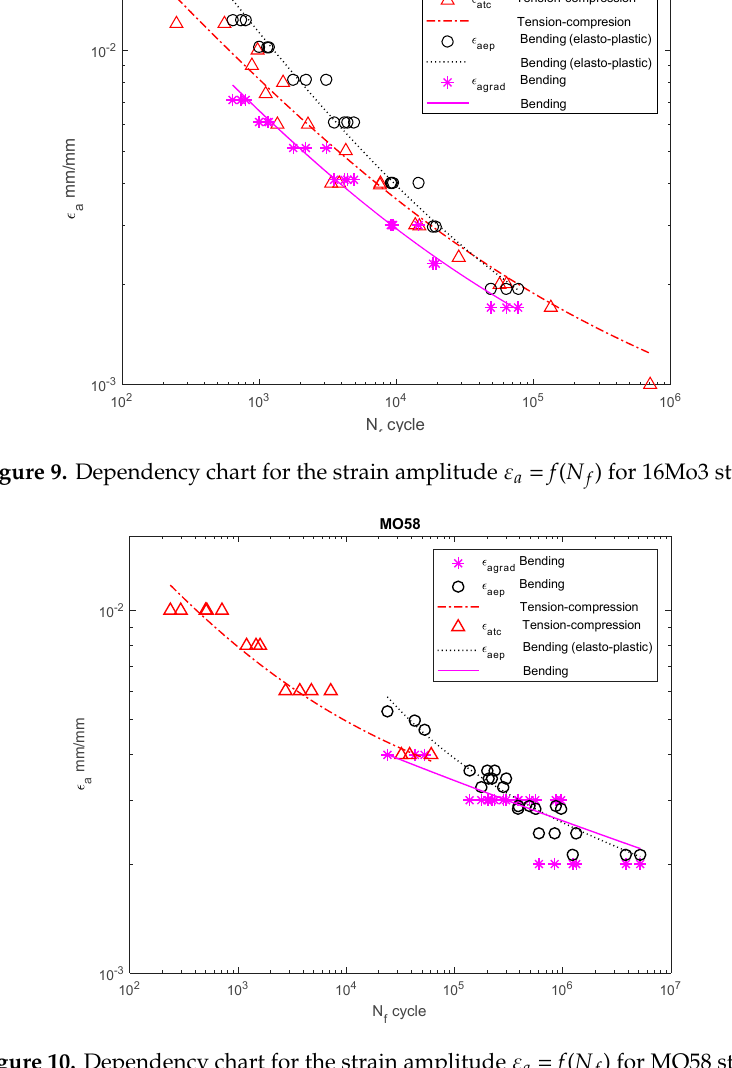
Figure 10. Dependency chart for the strain amplitude ε a = f ( N f ) for MO58 steel.